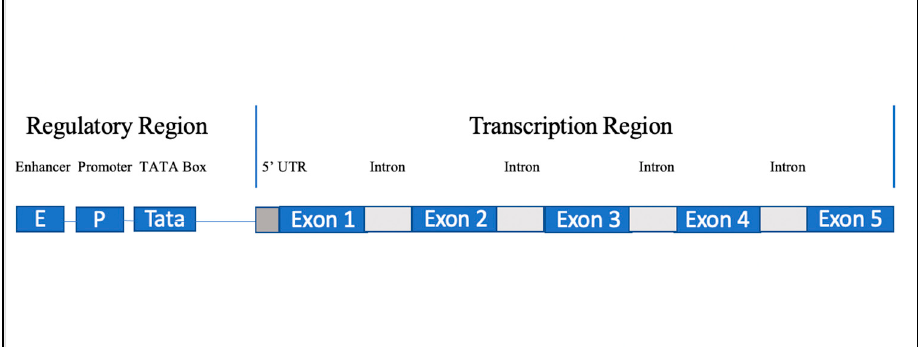
Figure 5. Simplified gene structure of ZNF469.